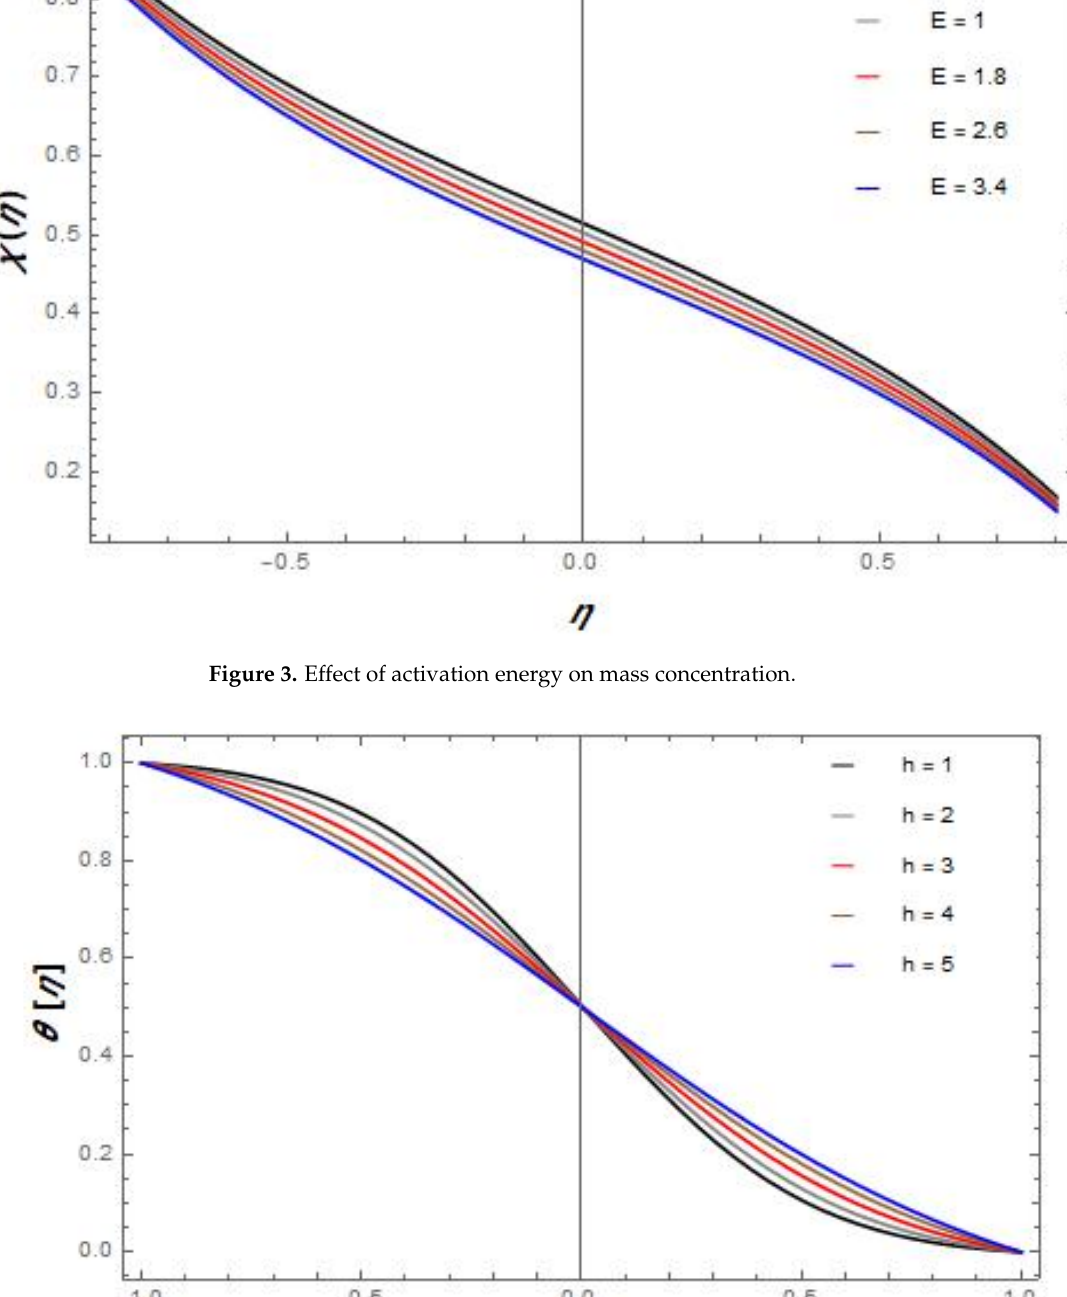
Figure 4. Effect of nanolayer thickness on the temperature profile.